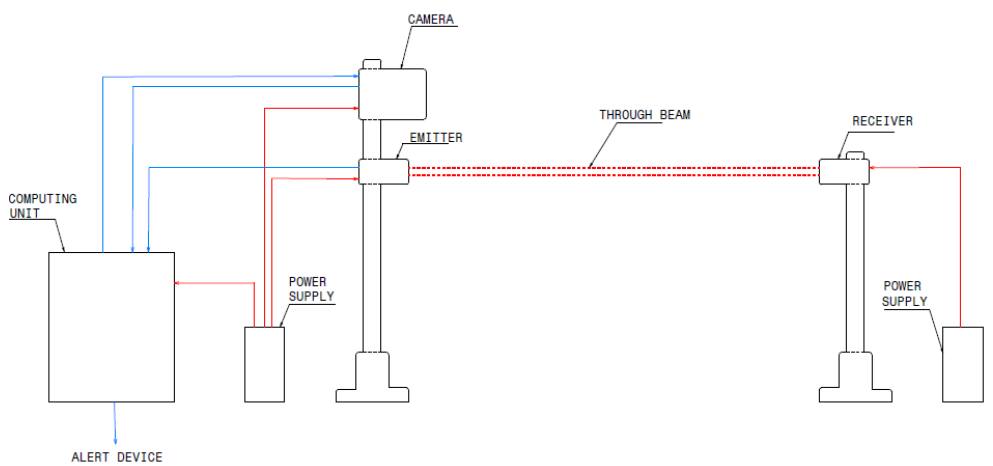
Figure 7. A proposed real-time roadside ADS with a computing unit that has machine learning models to detect animal species captured by the camera